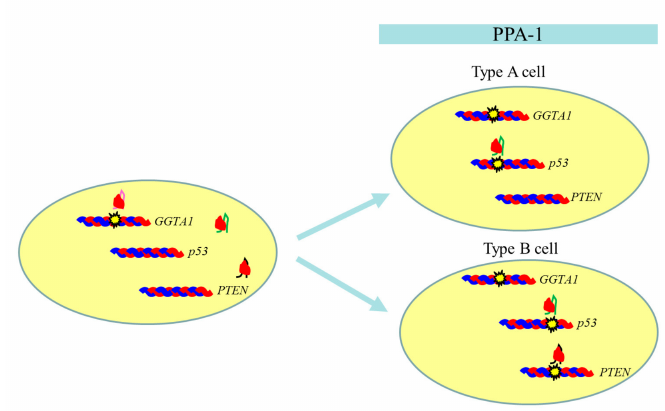
Figure 5. Possible mechanism underlying generation of two types of cells in PPA-1. When a cell is simultaneously transfected with three types of vectors (pCGsap1/PTEN, pCGsap1/p53, and pgRNA#3), hCas9/sgRNA (for GGTA1 ) complex is first transferred to GGTA1 to induce bi-allelic indels, thereby causing dysfunction of α -GalT. After cell division, two α -Gal epitope-negative daughter cells are generated. In one daughter cell, called type A, hCas9/sgRNA (for p53) complex attacks the target locus for the generation of bi-allelic indels, while PTEN locus remains intact. In the other daughter cell, called type B, hCas9/sgRNA (for p53) creates bi-allelic indels on a region different from that in type A cell, while PTEN locus is genome-edited by hCas9/sgRNA (for PTEN) to create bi-allelic